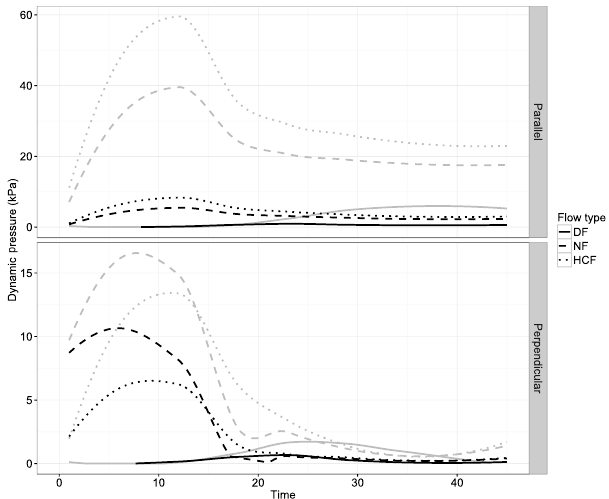
Figure 7. Comparison of mean pressure magnitude (grey lines) and mean normal pressure (black lines) on block West 2 in the parallel and perpendicular orientations for a 75m 3 s − 1 flow along Quebrada Dahlia.